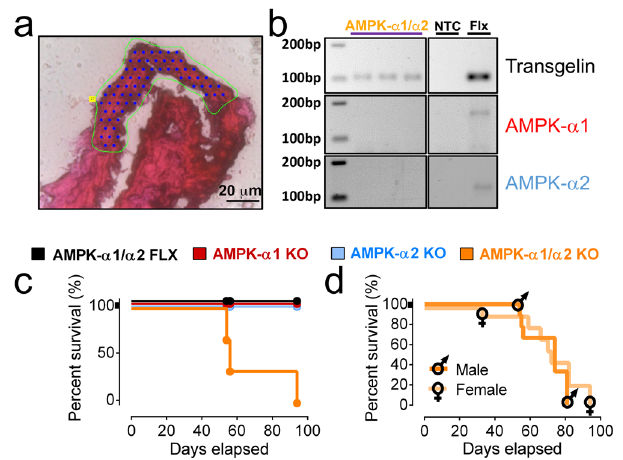
Fig.1|AMPK- α 1/ α 2deletionprecipitatesprematuredeath.a Exemplarimageof asectionofpulmonaryarterialmediaexcisedbylasermicrodissection. b Exemplar gelsforquantitativeRT-PCRampliconsfortransgelin,AMPK- α 1andAMPK- α 2taken from sections of the medial layer excised from pulmonary arterial sections from AMPK- α 1/ α 2 double knockout (KO) and AMPK- α 1/ α 2 fl oxed (FLX) mice by laser microdissection. NTC negative template control (eluate from the RNA extraction for which no sample material was added). c Kaplan – Meyer curves for AMPK- α 1/ α 2 FLX (black n =4, 2 males and 2 females), AMPK- α 1 knockouts (AMPK- α 1 KO; red, n =6, 3 males and 3 females), AMPK- α 2 knockouts (AMPK- α 2 KO; blue, n =7, 2 males and 5 females) and AMPK- α 1/ α 2 KO (orange, n =4, 2 males and 2 females). d RetrospectiveanalysiscomparingsurvivalratesforAMPK- α 1/ α 2KOmales( n =6) and females ( n